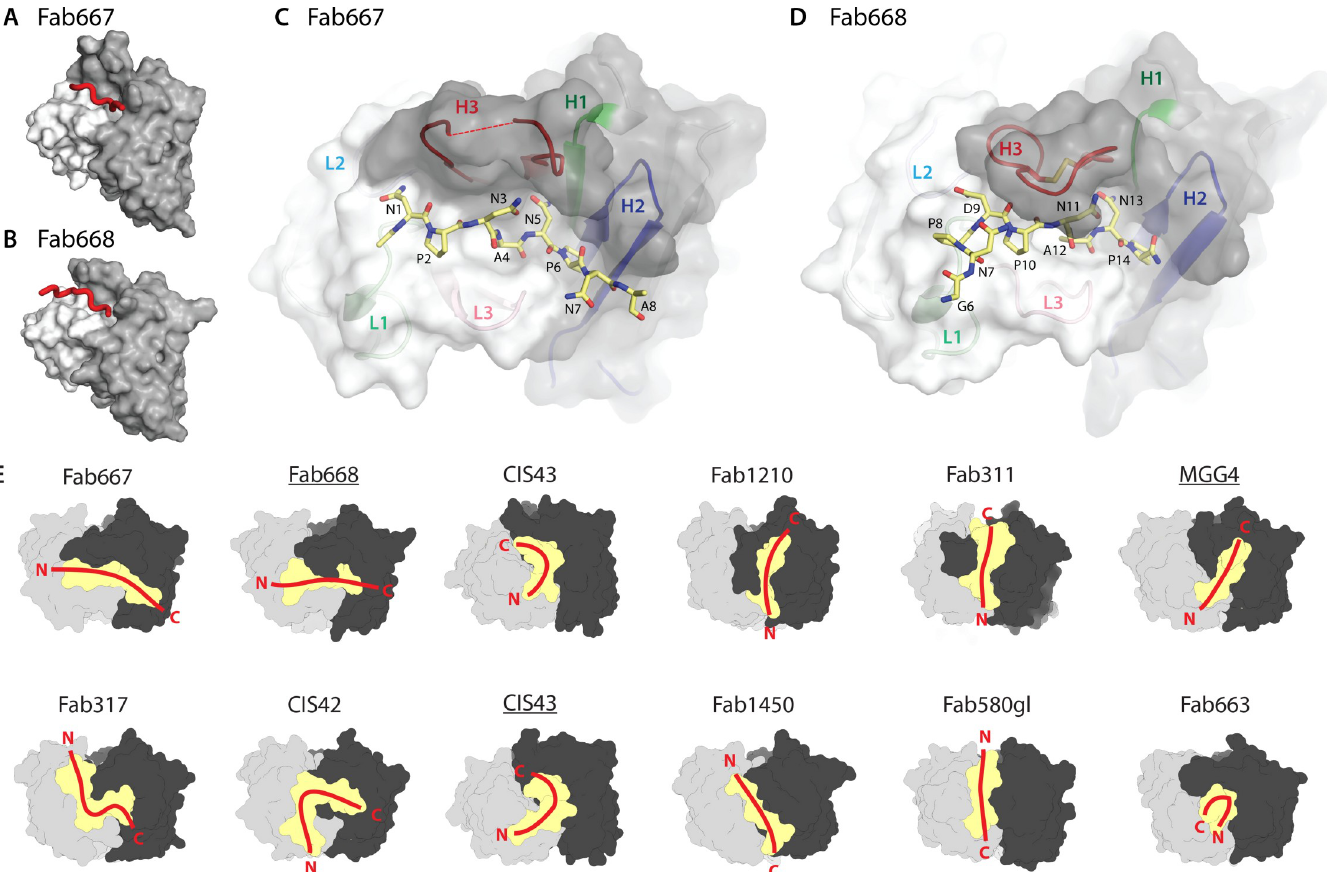
Fig 2. Structural analysis of binding of junctional and NANP repeat peptides to protective antibodies. Overview of the antibody paratopes for ( A ) Fab667 and ( B ) Fab668. The light and heavy chains are colored white and dark grey respectively. The peptide is shown as a red tube. Details of the paratopes and peptide conformation are shown for ( C ) Fab667 and ( D ) Fab668. Here the peptide is shown in the stick configuration (yellow carbons) and the residues are numbered. The CDR loops are colored according to their identity (H1: green, H2: blue, H3: red, L1: light green, L2: light blue and L3: pink). The tip of CDR H3 of Fab667 is disordered ( H Gly 100C ) and is connected to the rest of CDR H3 by a dotted red line. ( E ) Comparison of Fab667 and Fab668 interactions with CSP peptides in previously published Fab structures (Fab317 (PDB code 6AXL), Fab311 (6AXK) [14], MGG4 (6BQB) [16], CIS43 (6B5O, 6B5L) and CIS42 (6B5T) [17], Fab1210 (6D01) and Fab1450 (6D11) [23], Fab580gl (6AZM) and Fab663 (5BK0) [15]). Paratopes are shown as a yellow surface with the heavy chain in black and light chain in grey. The overall conformations of each peptide and relative orientations are shown as red lines with their N- and C-termini indicated. Underlined Fab labels indicate structures in complex with junctional